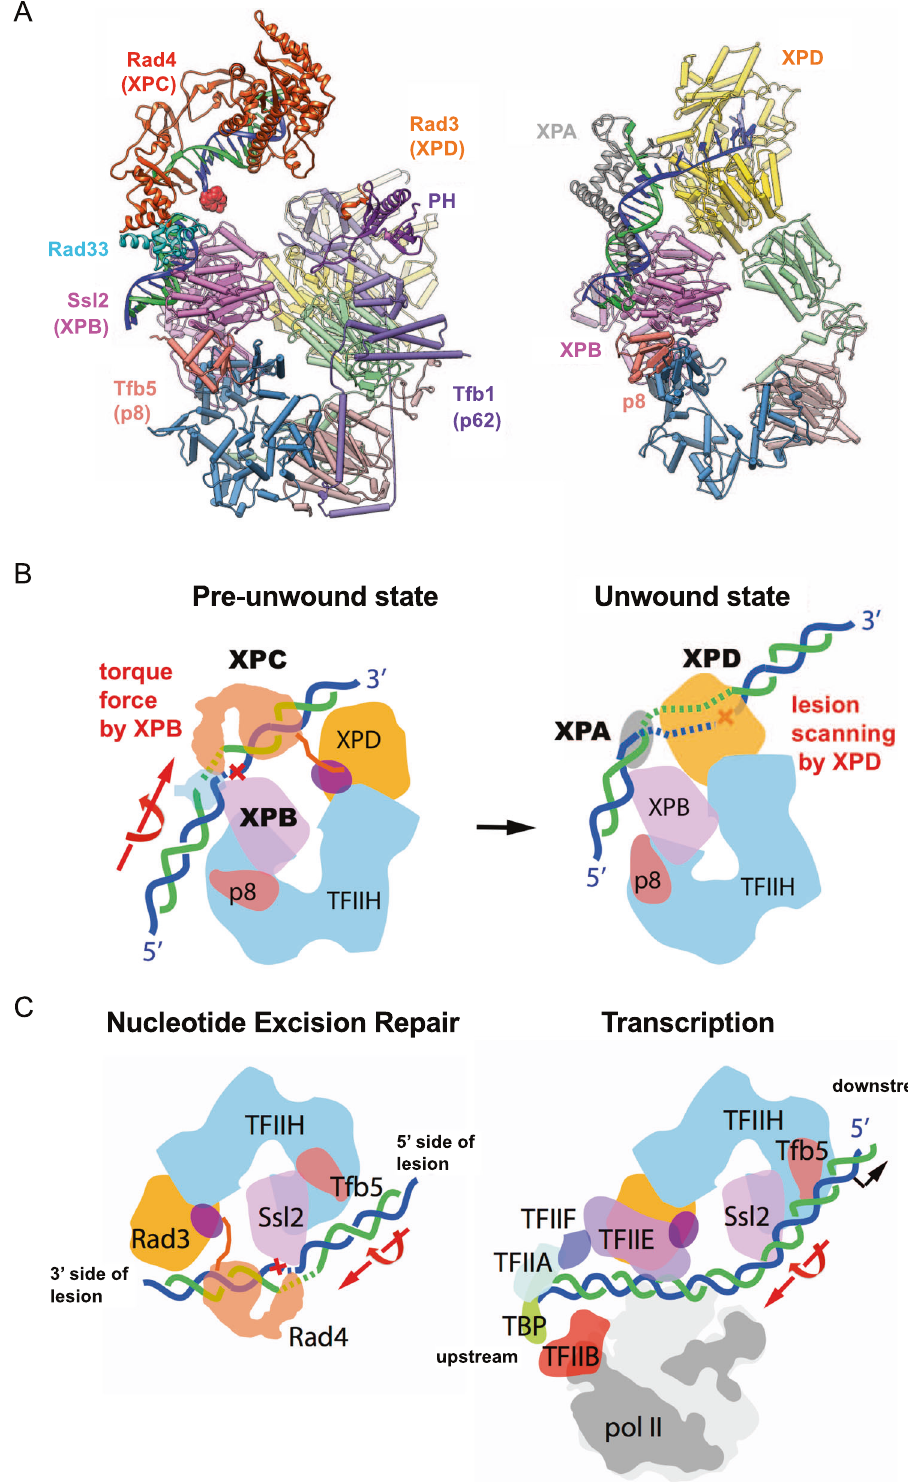
Finally, the multibody re fi nement of TFIIH provided an additional clue regarding the structural transition from the “ pre-unwound ” to “ unwound ” states: the striking ~30 Å movement of Ssl2-Tfb5-Tfb2C directed towards Rad3, brings the damaged strand into close proximity to the ssDNA-binding cleft of Rad3 (Supplementary Movie 4). Such movement may represent a transition state on the path to a stable “ unwound ” state. In our samples, however, such